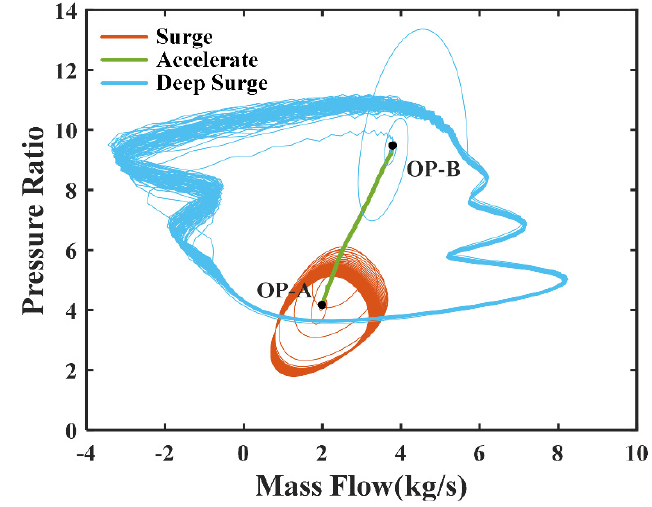
Figure 14. The engine’s operating trajectory in the surge dynamic process at multiple operating